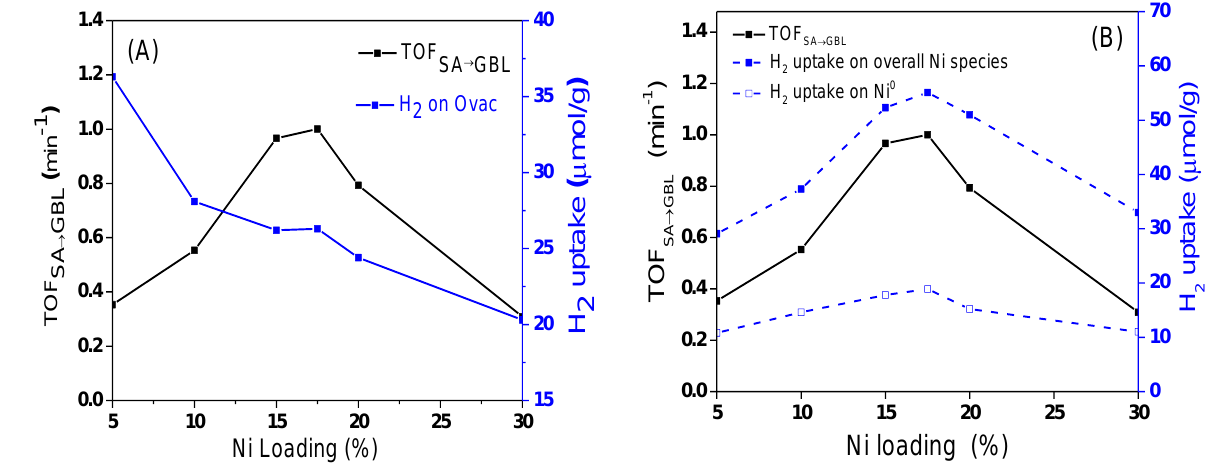
Figure 14. Effect of Ovac ( A ) and surface Ni species ( B ) on the TOF SA → GBL over the xNi/CeO 2 cata- lysts.